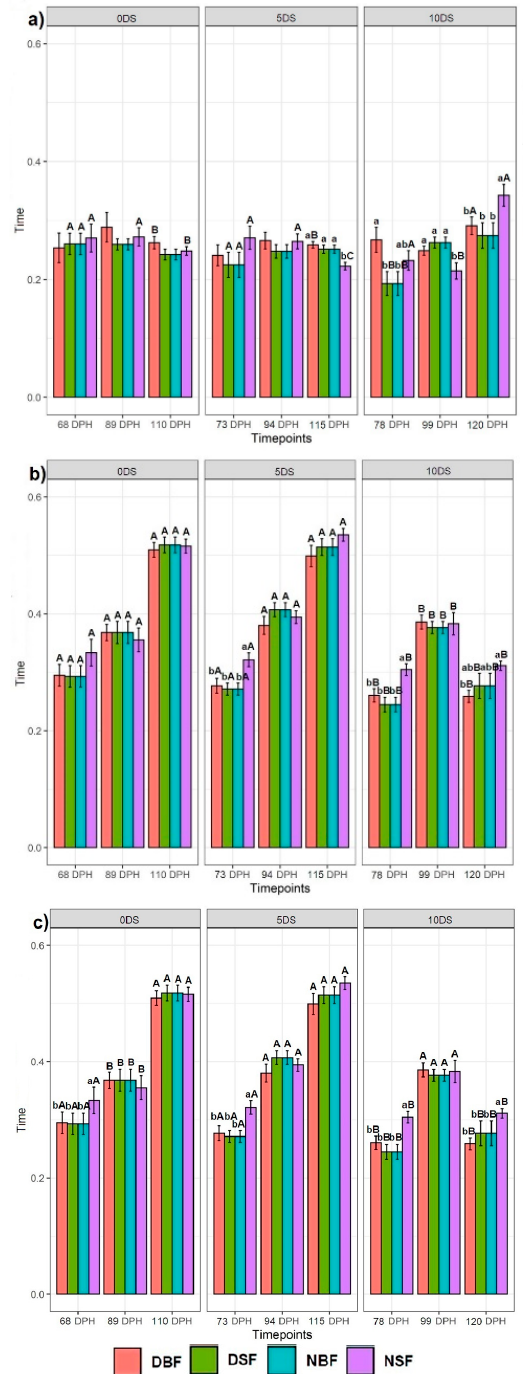
Figure 4. Effect of different feeding applications on the non-starved Siberian sturgeon (0 DS), starved for 5 days (5 DS), starved for 10 days (10 DS), and their swimming behaviour: ( a ) at the 25% bottom section of the tank; ( b ) at the 50% middle section of the tank; ( c ) at the 25% surface section of the tank. Letters denote significant differences, where the lowercase letters show the difference between feeding applications per recording day and per day of starvation for each tank section. The uppercase letters show the difference in each feeding application between 0, 5, and 10 days of starvation per tank